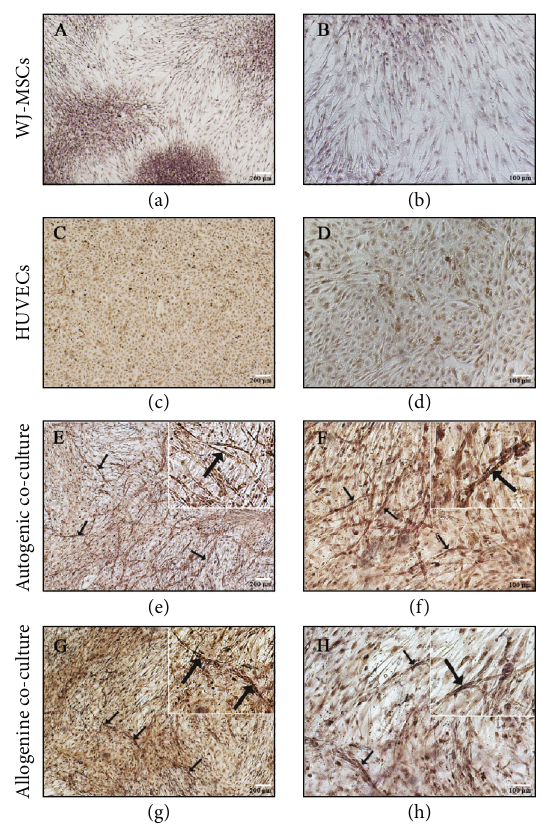
Figure 4: Vessel-like structure formation in 2-dimensional (2D) culture. After 3 days cultured in endothelial growth media, WJ- MSCs (a, b), HUVECs (c, d), autogenic (e, f), and allogenic (g, h) HUVECs/WJ-MSCs coculture were stained with antibodies directed against human CD31 (brown). Arrows indicated CD31 stained VLS in both of autogenic and allogenic HUVECs/WJ- MSCs coculture condition. Scale bar: 200 μ m (a, c, e, and g) and 100 μ m (b, d, f, and